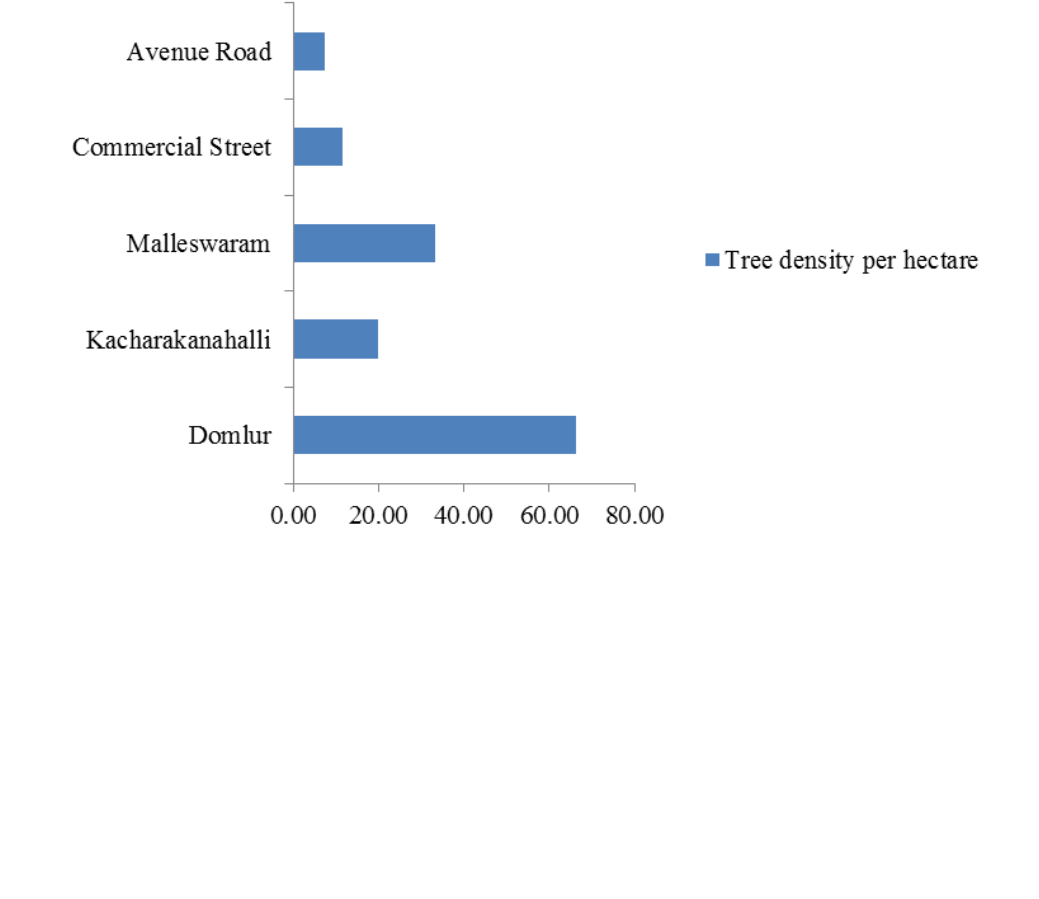
Figure 13. Density of trees in the five study locations in Bangalore, based on field